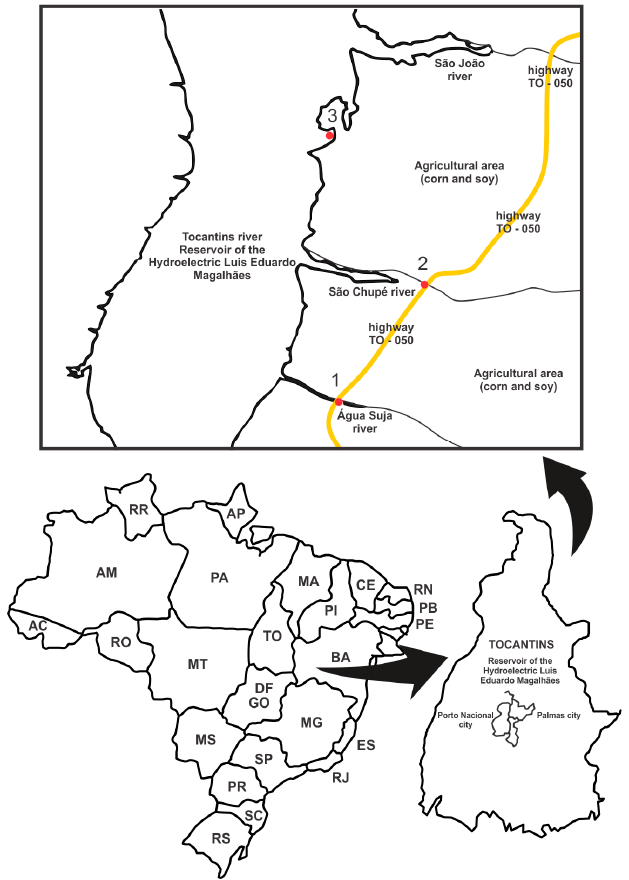
Figure 1. Geographic location of Tocantins River and the map of the collection sites.